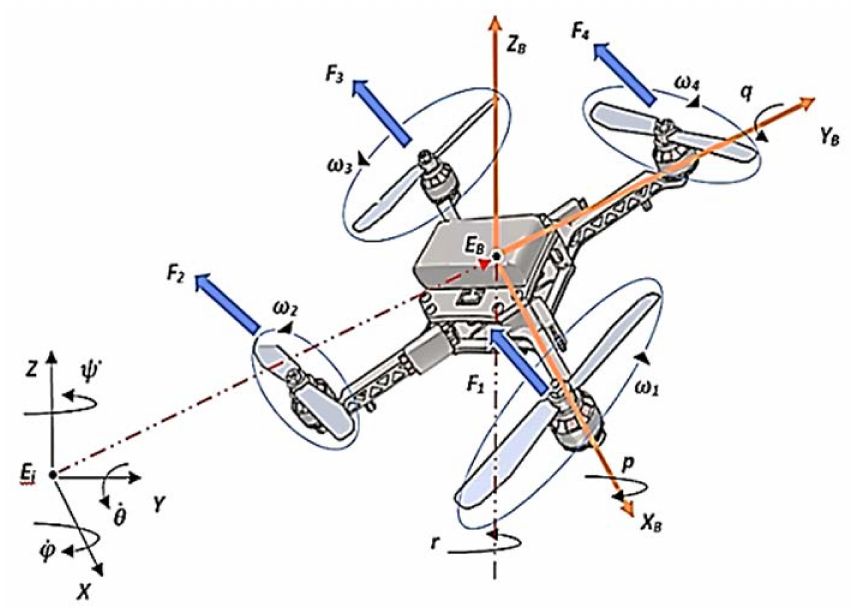
Figure 2. Physical Model of an Underactuated Quadrotor